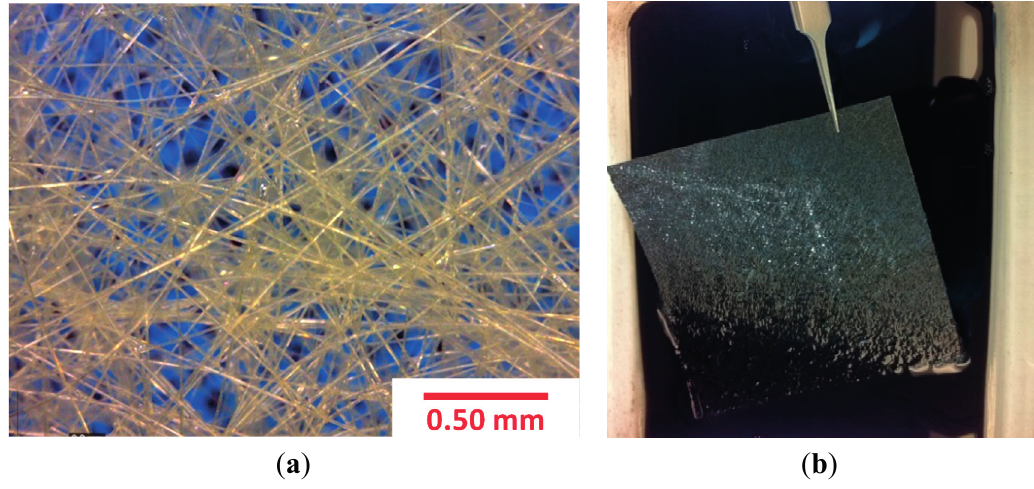
Figure 1. Photographs showing ( a ) porous fiber structure of the selected aramid nonwoven fabric (with porosity about 90%) and ( b ) a saturated aramid nonwoven fabric with CNTs following bath